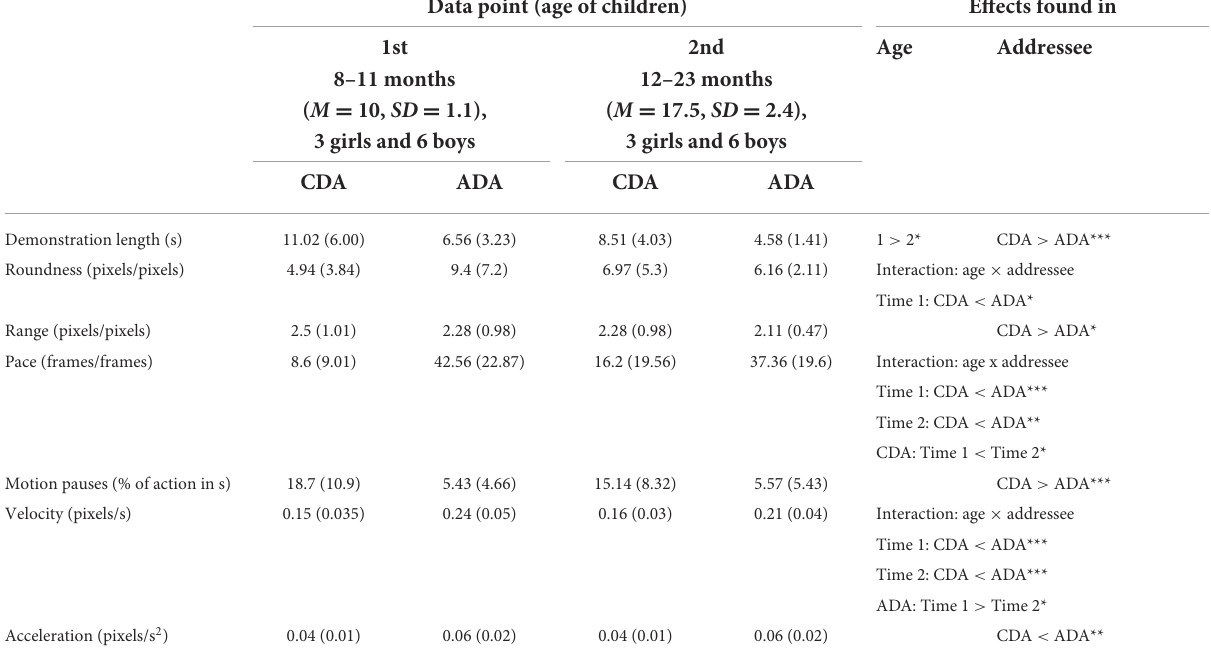
TABLE 3 Results from Study 2 along the parameters for action modifications conveying means, SDs , and significant effects ( * p < 0.05, ** p < 0.01, *** p < 0.001). Data point (age of children) Effects found